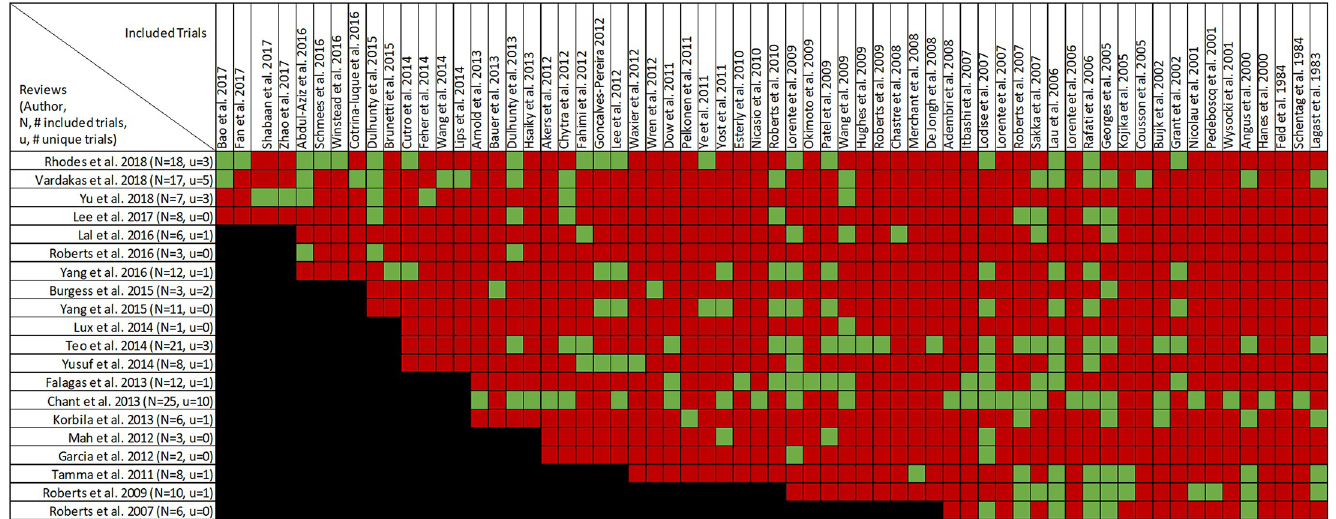
Fig 3. Citation matrix for reviews reporting mortality of prolonged infusions versus intermittent infusions of beta-lactams. Green—primary studies included in systematic review, Red—primary study not included in systematic review, Black—primary studies published after systematic review and therefore ineligible for possible inclusion.